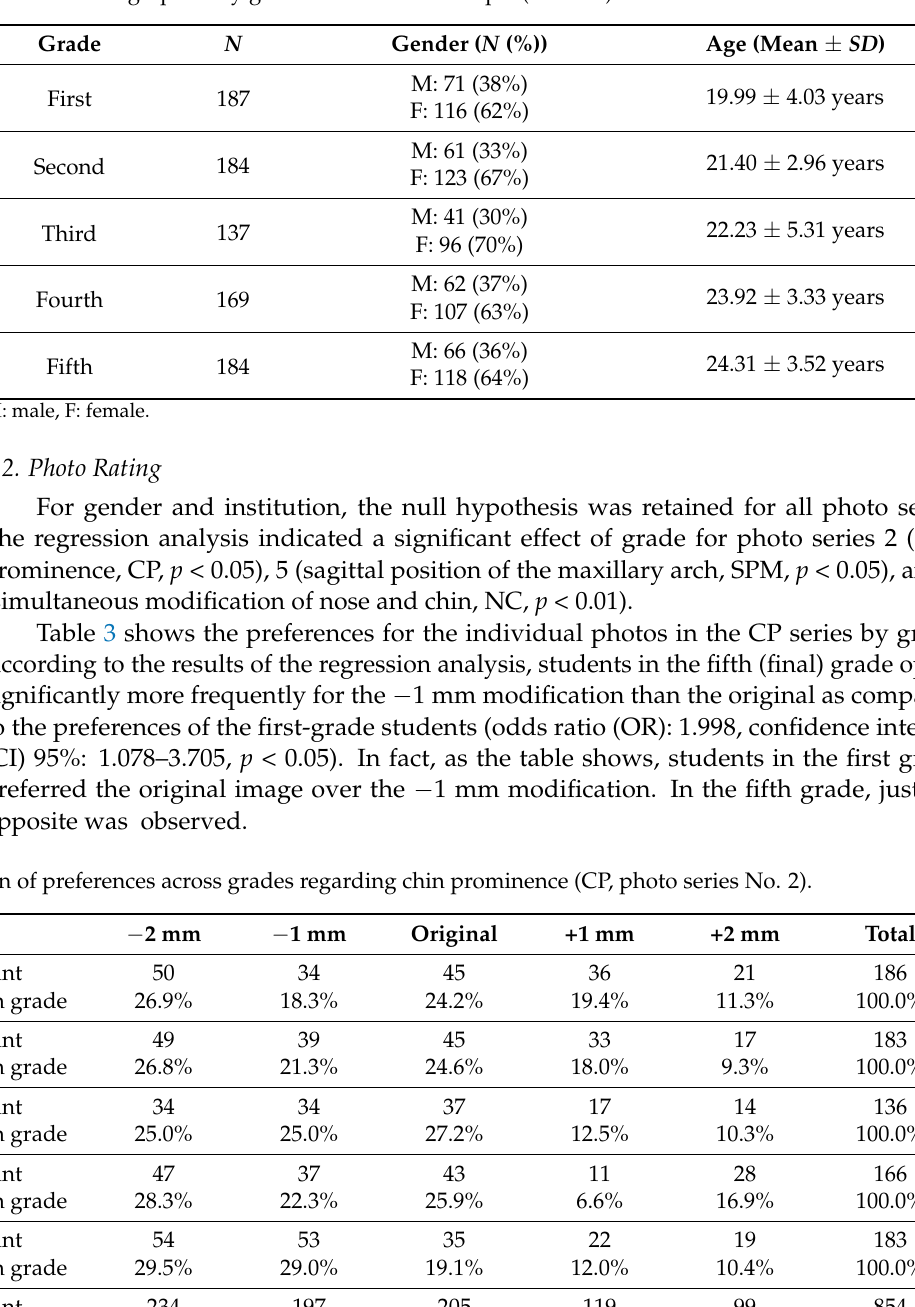
Table 2. Demographics by grade for the entire sample ( N = 861).